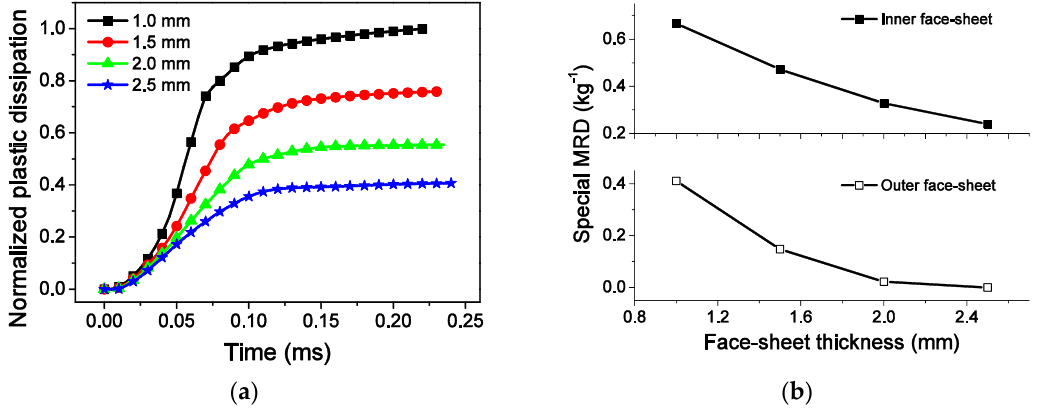
Figure 18. Influence of face-sheet thickness on EA and MRD. ( a ) EA, and ( b ) MRD.